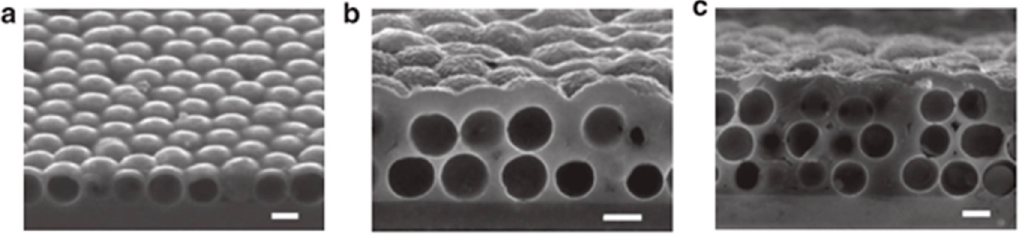
Figure 11. SEM images of: ( a ) one; ( b ) two; and ( c ) three layers of nanoshells [125]. Scale bars are 300 nm.